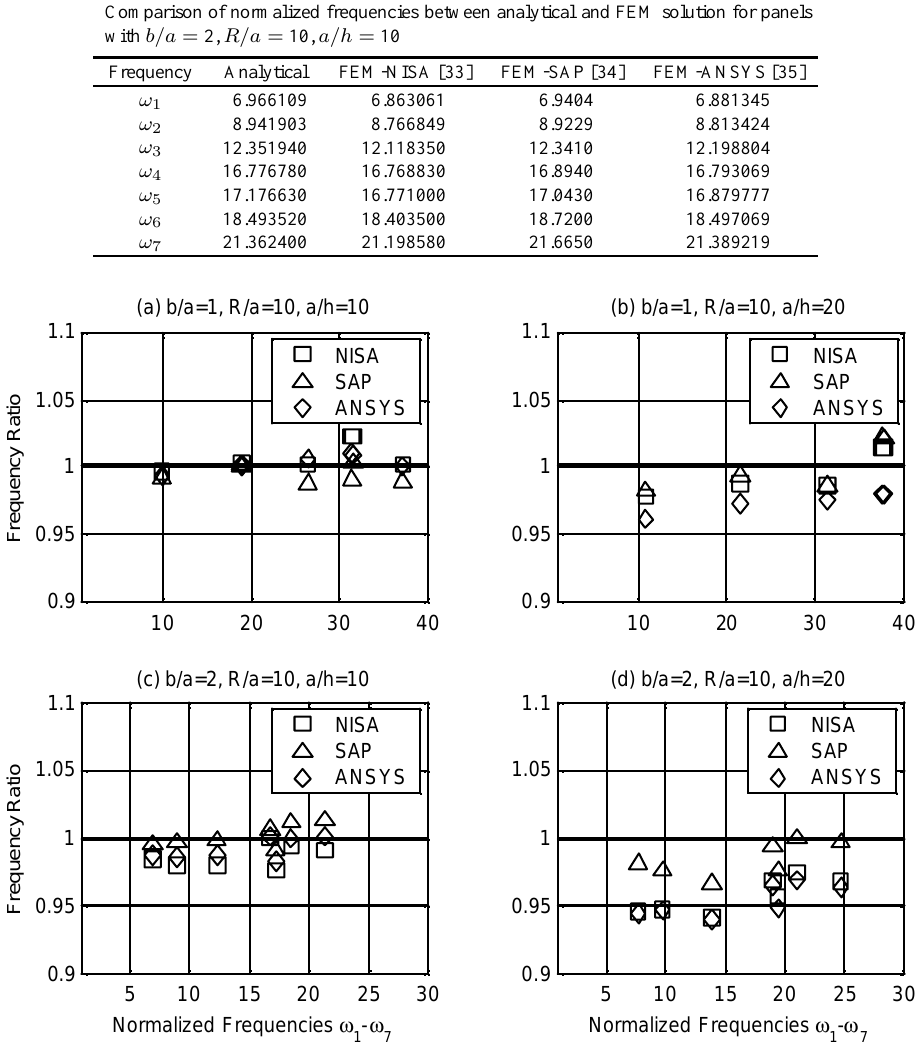
Fig. 7. a–d. Comparison of ratios of finite element solutions to analytical